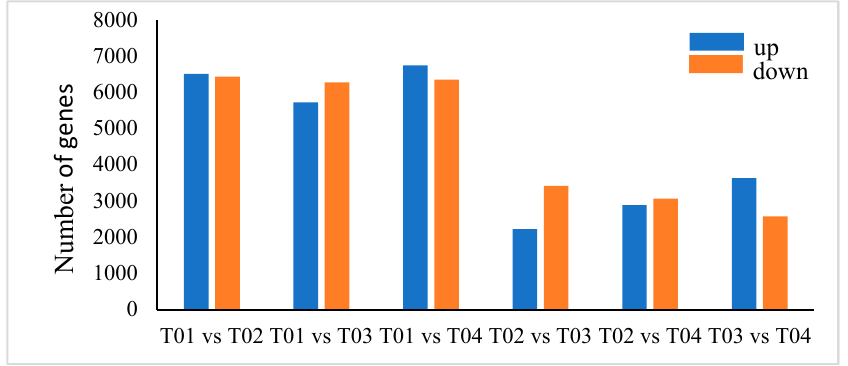
Figure 4. The numbers of up- and down-regulated genes among the four different stages.